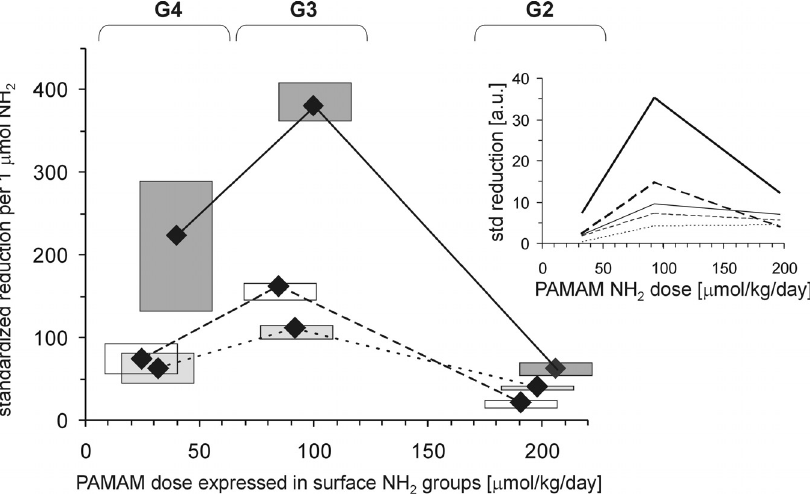
Figure 3. Relationship between the concentration of PAMAM surface primary amino groups and dendrimer-induced reduction in markers of prolonged hyperglycaemia in streptozotocin-diabetic rats. The data, which are presented as median and interquartile range (n = 5–19), represent standardised reductions in hyperglycamia/oxidation markers in Sprague-Dawley rats treated intraperitoneally with PAMAM dendrimers and are presented in arbitrary units [a.u.] or expressed per μ mol NH (HbA : thick dashed line; AGEs: thick dotted line; and CS: thick solid line). For more 1c details, see Figure 2 and the text. Insert: non-fasting glycaemia: thin dashed line; HbA thick dashed line; AGEs: thin solid line; AOPP: thin dotted line; and CS: thick solid line. The significance of the differences between PAMAM dendrimers was: μ p < 0.005 or less for all